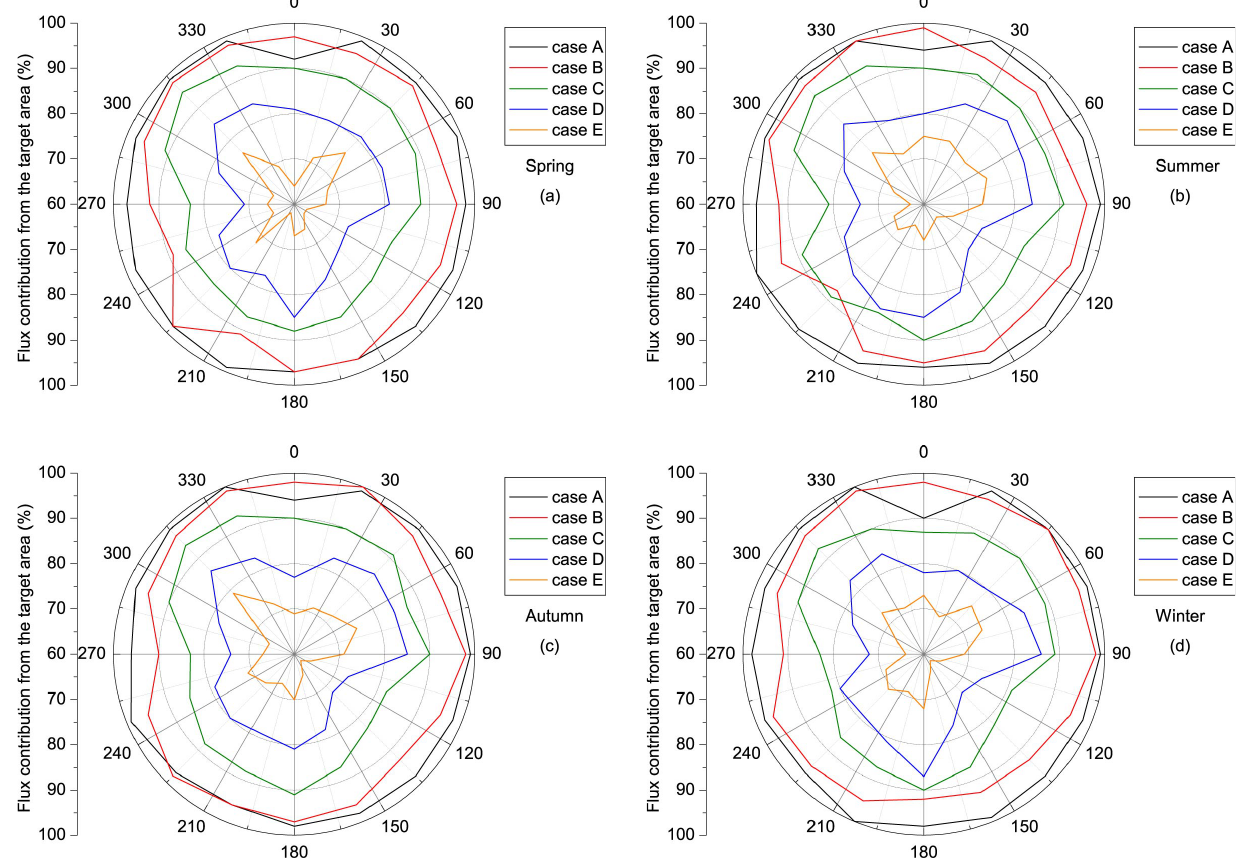
Fig. 8. Eddy covariance flux contribution from the target zone (%) in different wind directions and stability at SACOL site for (a) spring, (b) summer, (c) autumn, and (d) winter. Case A stands for ζ ≤− 0.2, B for − 0.2 <ζ ≤− 0.0625, C for − 0.0625 <ζ ≤ 0.0625, D for 0.0625 <ζ ≤ 0.2, E for ζ > 0.2 (the definition of